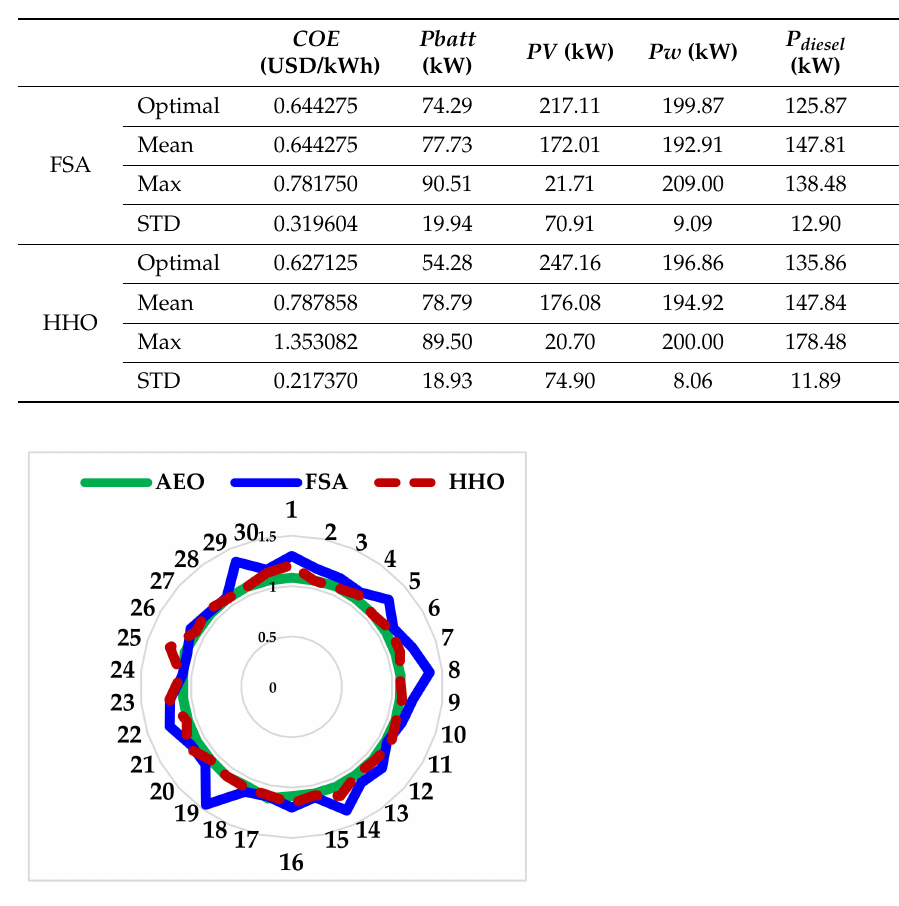
Figure 11. Fitness for cost of energy with DSM at 40% REF and 0% LPSP.